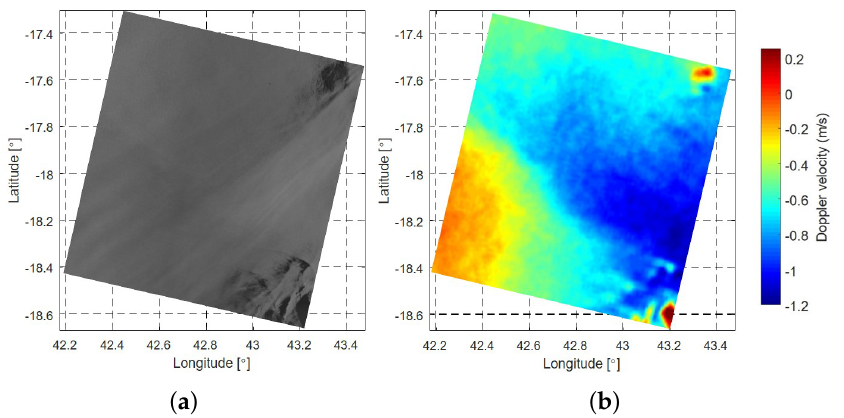
Figure 5. GF-3 SAR ( a ) amplitude image and ( b ) radial Doppler velocity.